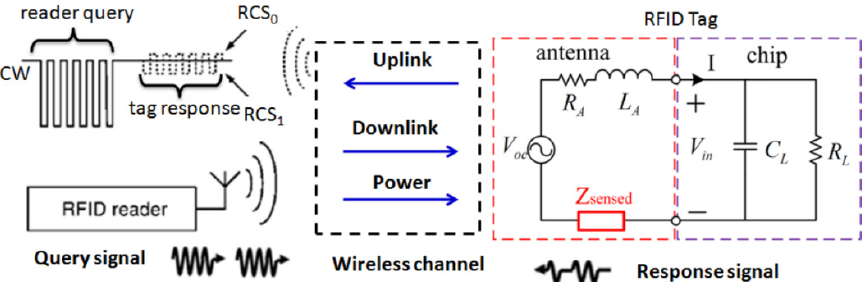
Figure 19. Schematic of a passive radio-frequency identification (RFID) antenna sensor system including a RFID tag, a reader, and antennas [209].